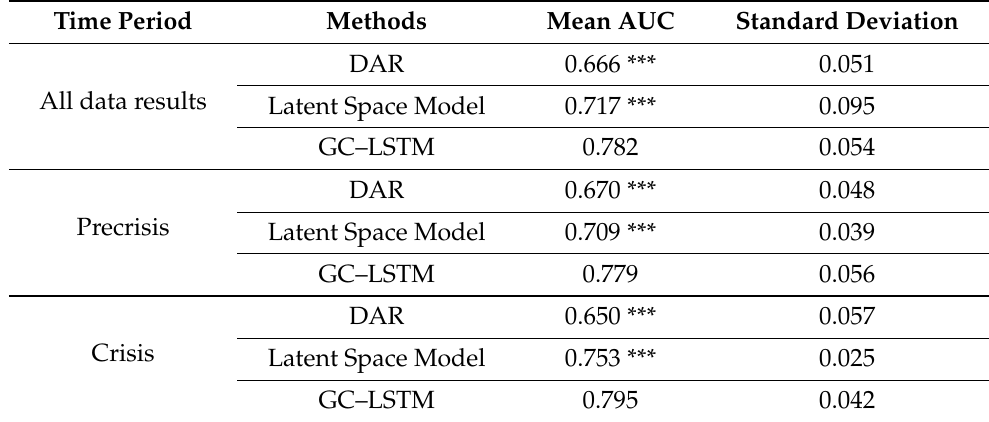
Table 5. AUC score for three models in the core country banks. The significance level of 1% (***) is used to assess the mean difference between the benchmark models (DAR or Latent space model) and the GC–LSTM model with the t -test.